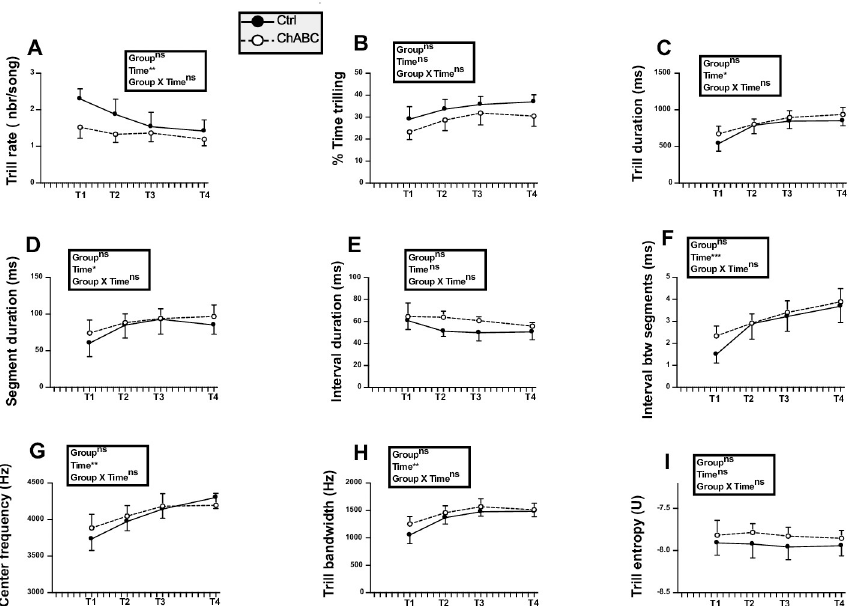
Fig 9. Trill rate and trill features during the fall of experiment 2 after all males had been treated with exogenous testosterone (T1 to T4). Data were analyzed by two-way ANOVA with groups as independent factor and time as a repeated factor and results are summarized in the insert for each panel. N = 8 Ctrl and 7 ChABC males. ChABC: 1.83 ± .66 ng/ml; F = 2.01, p = 0.1737) but the data from these males were 1,18